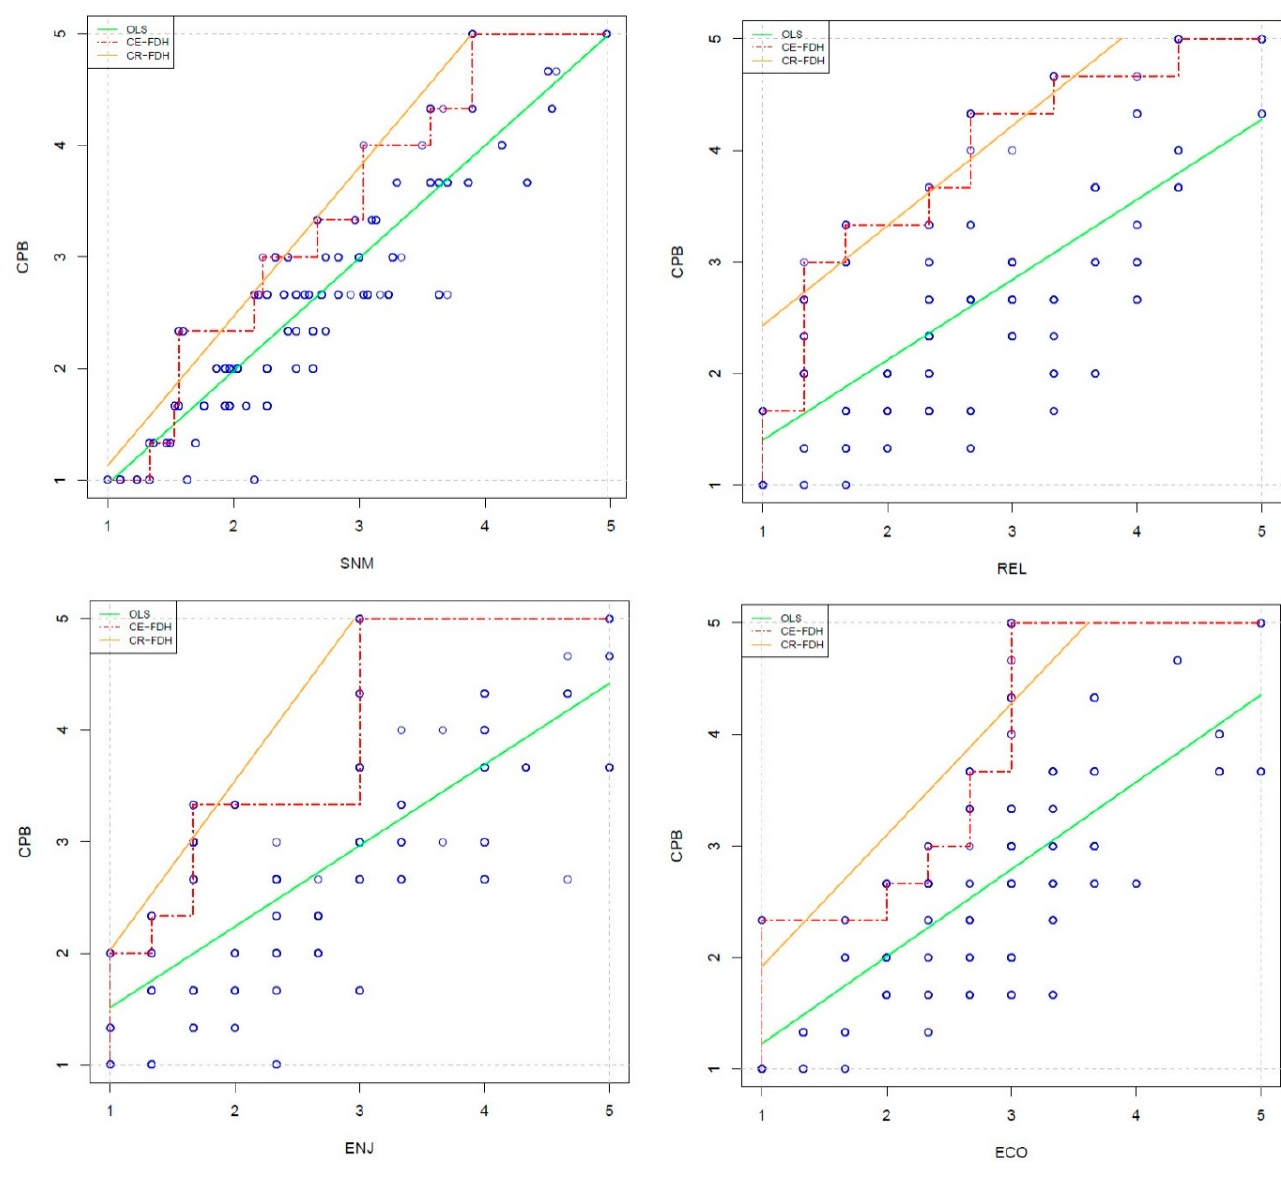
Table 8. Bottleneck table and NCA effect sizes.